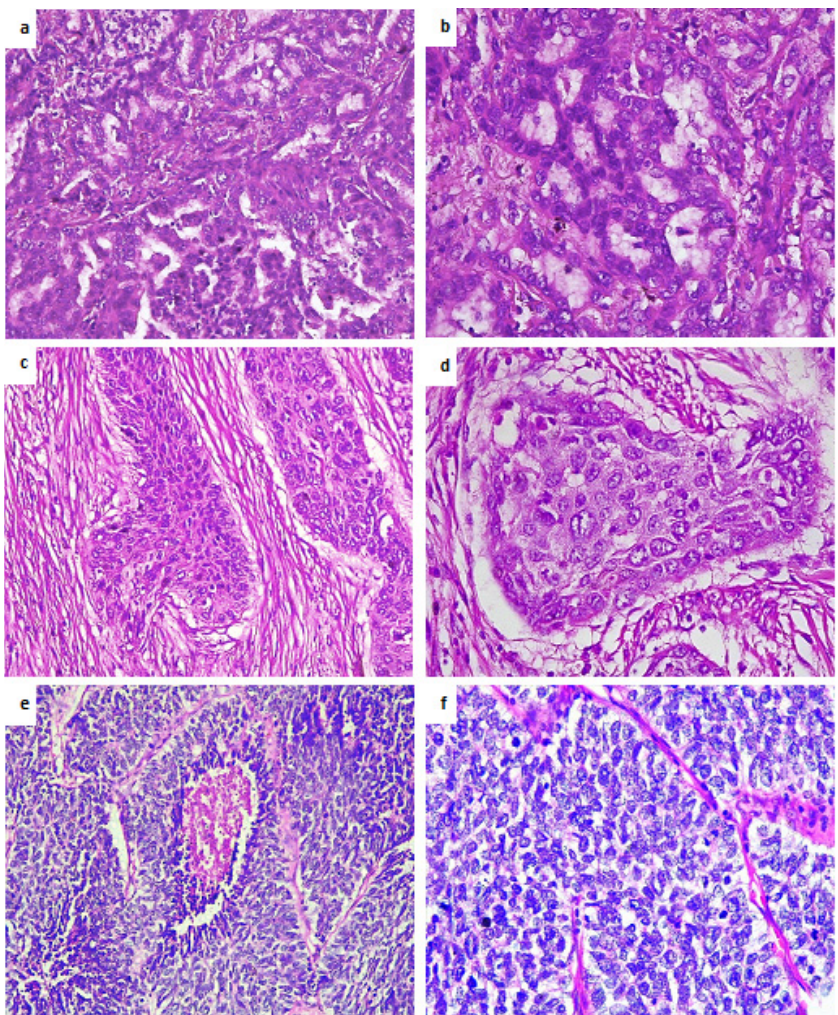
Figure 4. Hematoxylin–eosin staining of lung tumor tissue samples: ( a ) Lung adenocarcinoma at 200× magnification, showing classical glandular architecture; ( b ) Lung adenocarcinoma at 400×, nuclear atypia, nuclear polymorphism and cytoplasmatic secretion vesicle; ( c ) Lung squamous cell carcinoma at 200×, presenting islands of large polygonal cancer cells disposed of in a fibrous stroma; ( d ) High-magnification of a lung squamous cell carcinoma, 400×, showing the morphological details of the malignant cells with large adherent and polygonal cells, atypical and polymorph nuclei and presence of mitoses; ( e ) Small-cell lung carcinoma at 200× magnification showing a hypercellular tumor consisting of cells with round, oval nuclei, and scant cytoplasm, ill-defined cellular borders with a central zone of necrosis. ( f ) SCLC at 400× magnification highlights characteristic nuclear features such as nuclear molding, finely dispersed chromatin pattern, absence of nucleoli and presence of multiple mitoses.